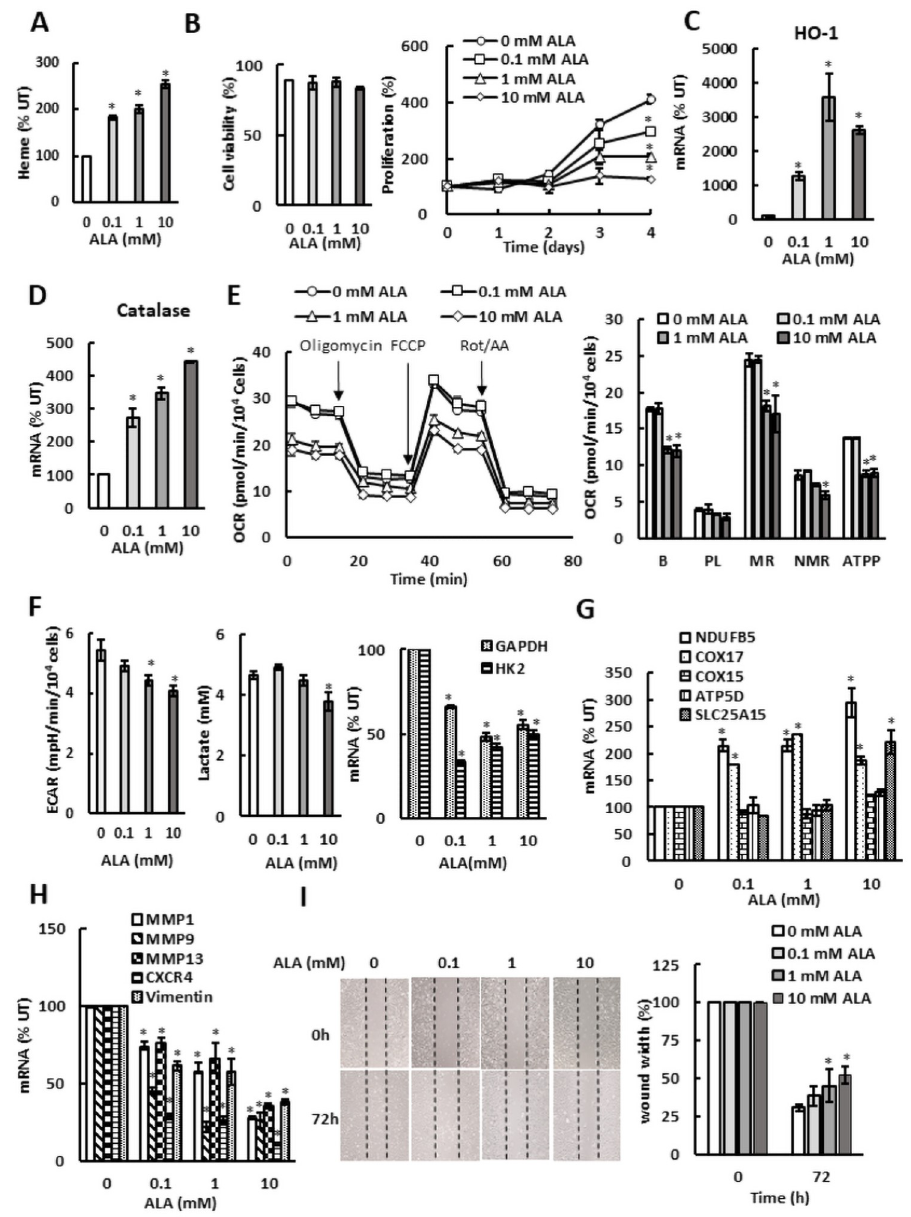
Fig 1. ALA inhibits mitochondrial respiration and aerobic glycolysis in SKOV3 cells. (A) Cellular heme levels in SKOV3 cells treated with ALA. Results are shown in comparison with untreated cells (%UT; 0 mM ALA). (B) Cell viability and proliferation. (C) HO-1 and (D) catalase mRNA analyzed by qRT-PCR in SKOV3 cells treated with ALA for 24 h. (E) Oxygen consumption rate (OCR) was measured in SKOV3 cells treated with ALA for 24 h. OCR was measured under basal conditions followed by the sequential addition of oligomycin (1.5 μ M), FCCP (0.5 μ M), and rotenone & antimycin A (Rot/AA; 0.5 μ M) as indicated. Each data point represents an OCR measurement. Derived respiratory parameters are basal respiration (B), proton leak (PL), maximal respiration (MR), non-mitochondrial respiration (NMR), and ATP production (ATPP). (F) Extracellular acidification rate (ECAR), lactate accumulation in the medium, and GAPDH and HK2 mRNA levels in SKOV3 cells treated with ALA for 24 h. (I) Expression of metastatic genes in SKOV3 cells treated with ALA for 24 h. (G) Expression of ETC and OXPHOS genes measured by RT-PCR in SKOV3 cells treated with ALA for 24 h. (H) Expression of metastatic genes in SKOV3 cells treated with ALA for 24 h. (I) Migration of SKOV3 cells treated with ALA for 72 h analyzed by wound healing assay (n = 3, magnification: × 10). (A-I) The experiments were repeated three times, and the numerical results are shown as means ± S.D. Values that are statistically different ( p < 0.05) from the control (untreated cells) are indicated by an